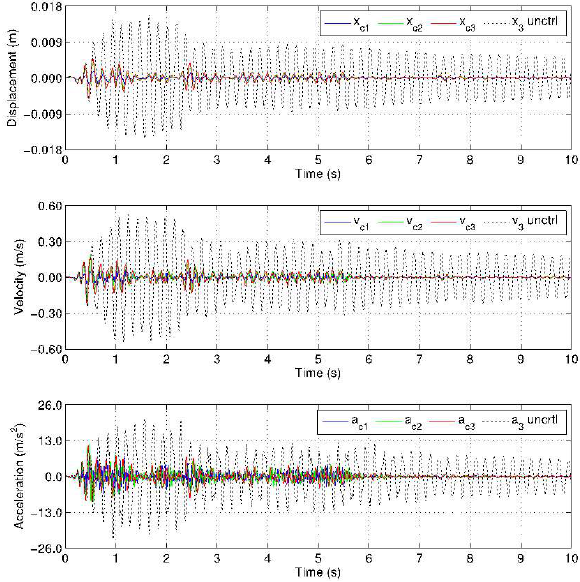
Figure 7: Uncontrolled response of the 3DOFs